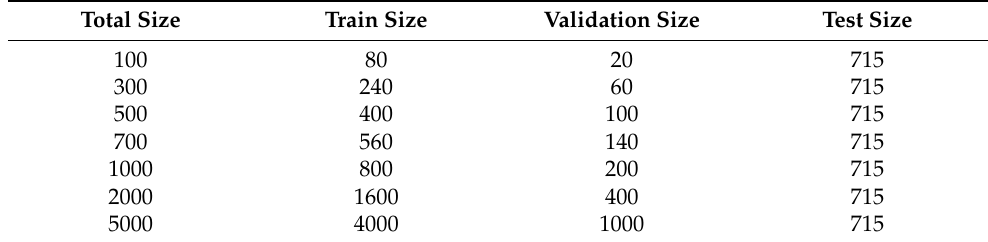
Table 1. Information about the reorganized